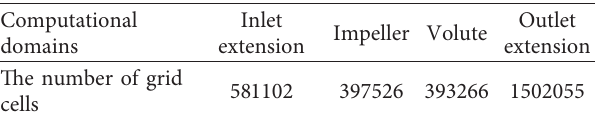
Table 2: The number of grid cells.